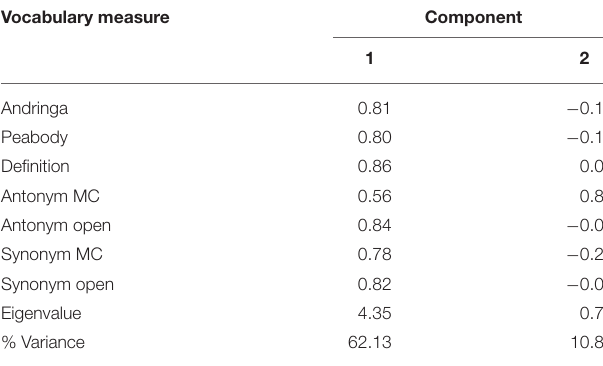
TABLE 3 | Results of the Principal Component Analysis assuming two components. Vocabulary